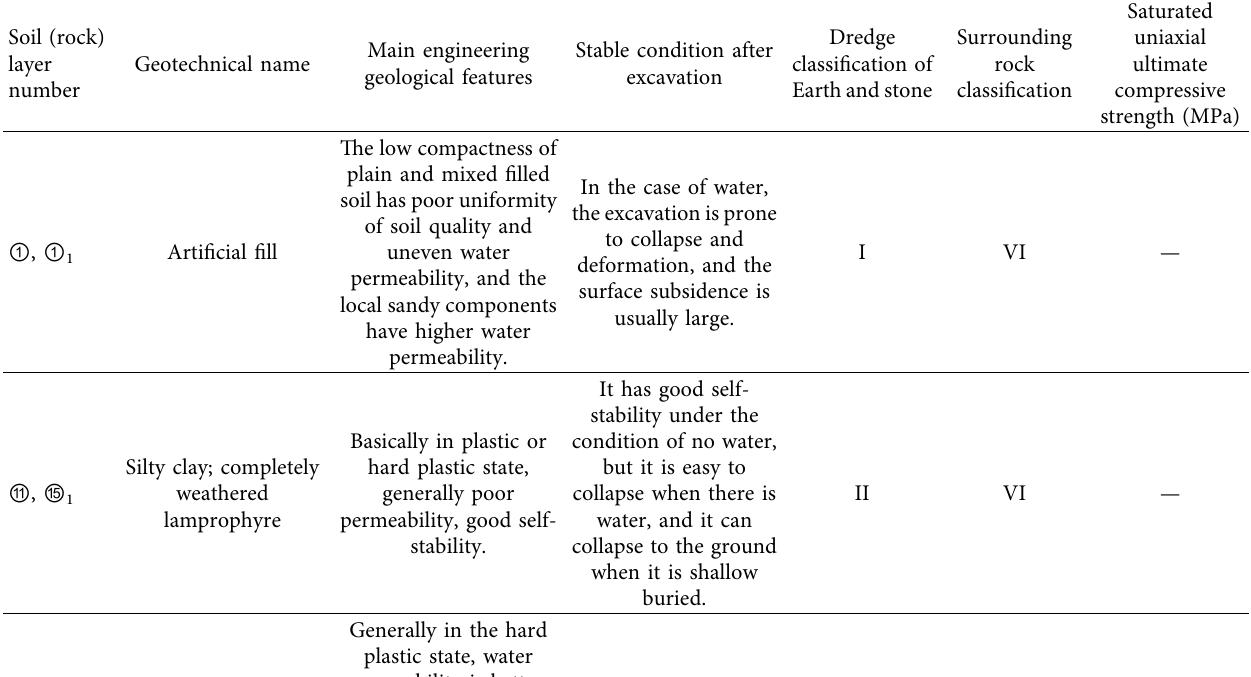
Table 1: Underground excavation station main Earth and rock excavation classification and tunnel surrounding rock classification. Soil